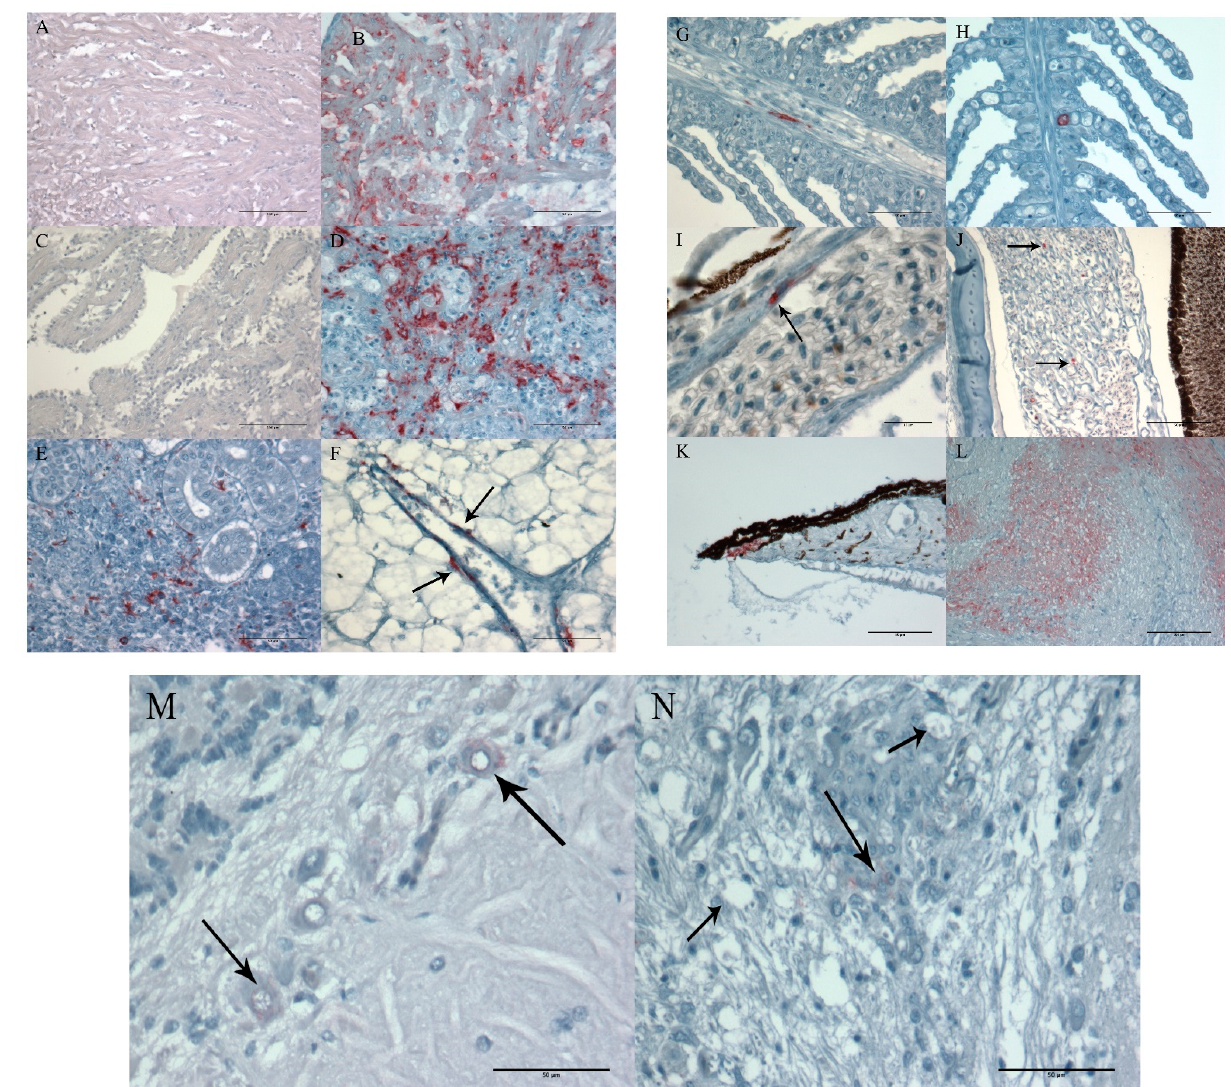
Figure 4. ( A – N ) Immunohistochemistry (IHC) (red) staining of paraffin sections of various organs from Atlantic cod ( Gadus morhua ) juveniles, using the monoclonal anti-VHSV IP5B11 serum, ABC-AP enzyme system and visualised with fuchsin. Positive IHC is visualised by red colouring of tissue. Shandon haematoxylin was used as counterstaining, giving the tissue different tones of blue. ( A ) Heart from control fish sampled 14 days post challenge (dpc), with no positive staining. Scale bar 100 µ m. ( B ) Heart from same individual as in Figure 4B, showing positive immunostaining in myocardium and endocardium. Notice the lack of positive staining of the epicardium. Scale bar 50 µ m. ( C ) Showing activation of the reticuloendothelial system (RES), 28 dpc. Scale bar 100 µ m. ( D ) Spleen of same individual as in Figure 4C, showing positive staining of the hematopoietic tissue. Scale bar 50 µ m. ( E ) Head kidney sampled 6 dpc showing positive immunostaining in the interstitium. Scale bar 50 µ m. ( F ) Liver sampled 6 dpc showing positive staining of cells associated with blood vessel (arrows). Scale bar 50 µ m. ( G ) Gills from fish sampled 6 dpc showing positively stained cells associated with blood vessel in the primary lamellae. Scale bar 50 µ m. ( H ) Gills from recently died fish 12 dpc, showing positive staining aligning the endothelia of the capillary in the secondary lamellae. Scale bar 50 µ m. ( I ) Corpus choroidale from an eye, sampled 7 dpc, showing positive endothelial-like cells (Arrow). Scale bar 15 µ m. ( J ) Corpus choroidale from an eye sampled 14 dpc with positively stained circulating cell (leukocyte-like cells) in the capillary system (arrows). Scale bar 50 µ m. ( K ) Positive immunostaining of iris from recently died fish 16 dpc. Scale bar 50 µ m. ( L ) Intestine of same individual as in Figure 4D showing positive immunostaining in muscularis circularis and muscularis transversum. Scale bar 100 µ m. ( M ) Brain from fish 28 dpc showing positive staining of neurons in metencephalon (Arrows). Scale bar 50 µ m. ( N ) Brain from fish 28 dpc showing metencephalon with a cluster of inflammatory-like cells with some positive staining (large arrow). Vacuoles are shown using small arrows. Scale bar 50 µ